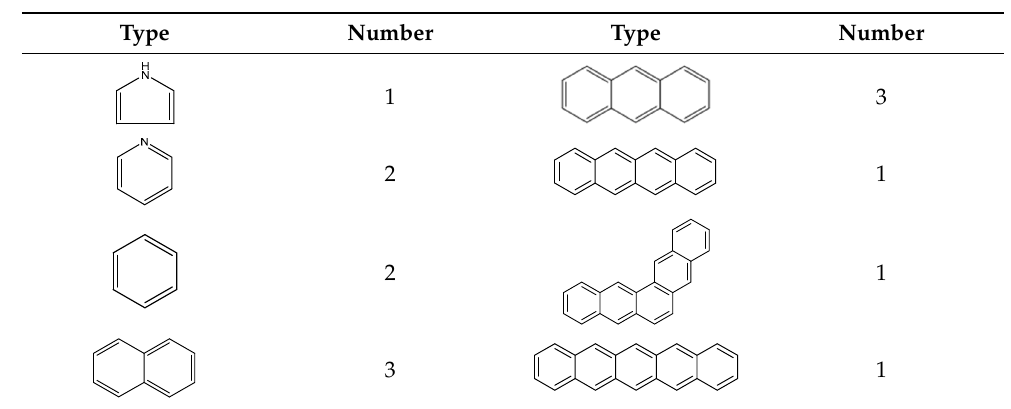
Table 5. The types and numbers of aromatic structures in gas coal.